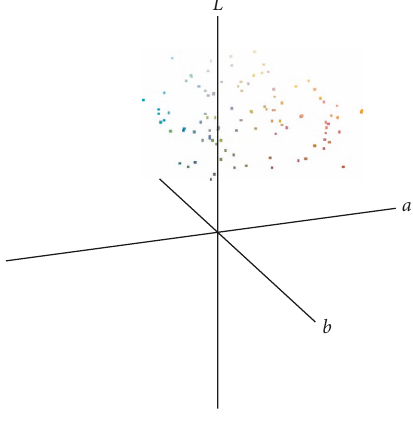
Figure 5: Set of color samples used for model validation.